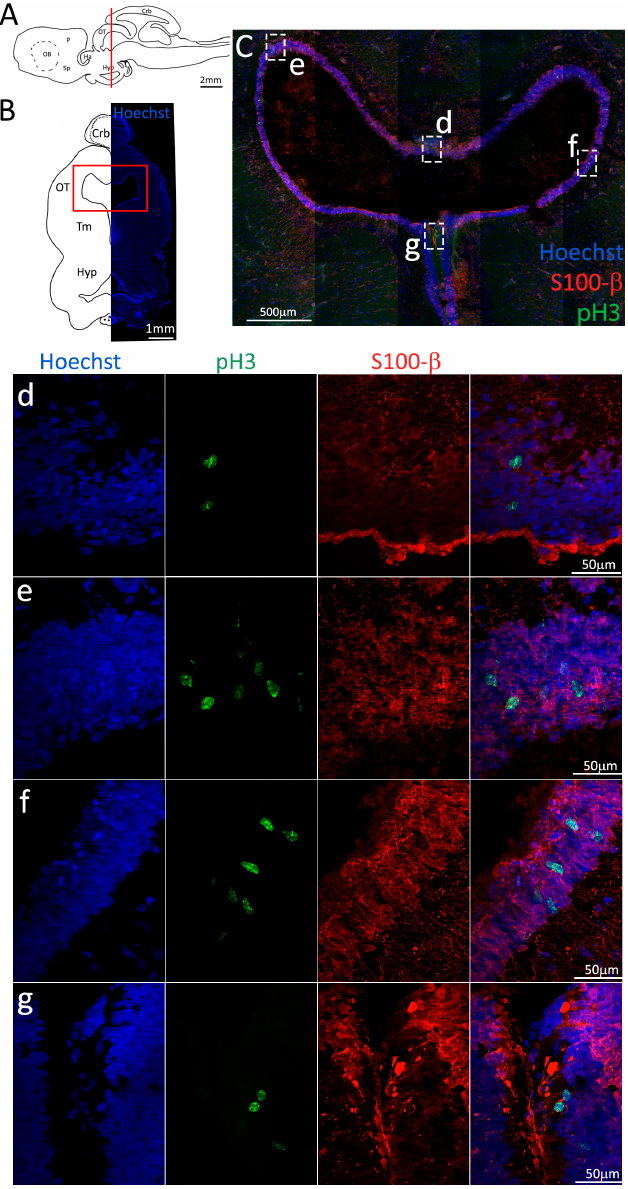
Figure 11. Localization of pH3 (green) and S100 β (red) positive cells in the mesencephalon of S. canicula . ( A ) Sagittal representation of S. canicula brain. The red line indicates the rostro-caudal localization of the section represented in the panel. ( B ) Coronal map of the area imaged. On the right, a real coronal section is stained with Hoechst 33342 to show nuclei distribution; on the left, a cartoon is drawn to indicate anatomical references. Red rectangle identifies the general area from which images are taken. ( C ) Mesencephalic neurogenic niche. ( d , e ) Magnification of the neurogenic